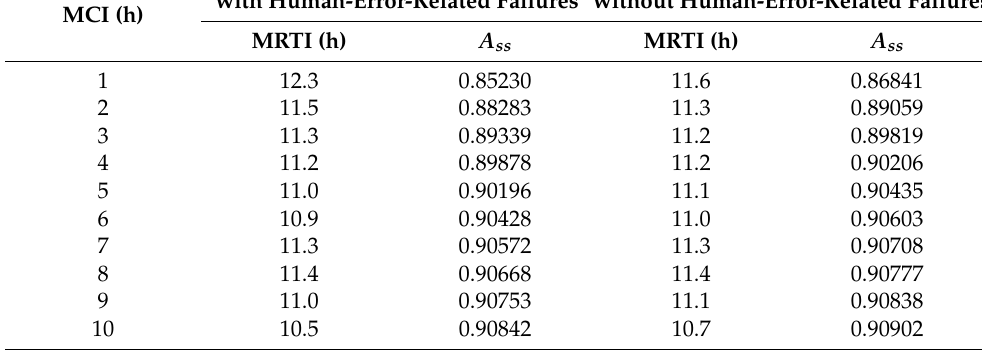
Table 8. Optimal rejuvenation-trigger